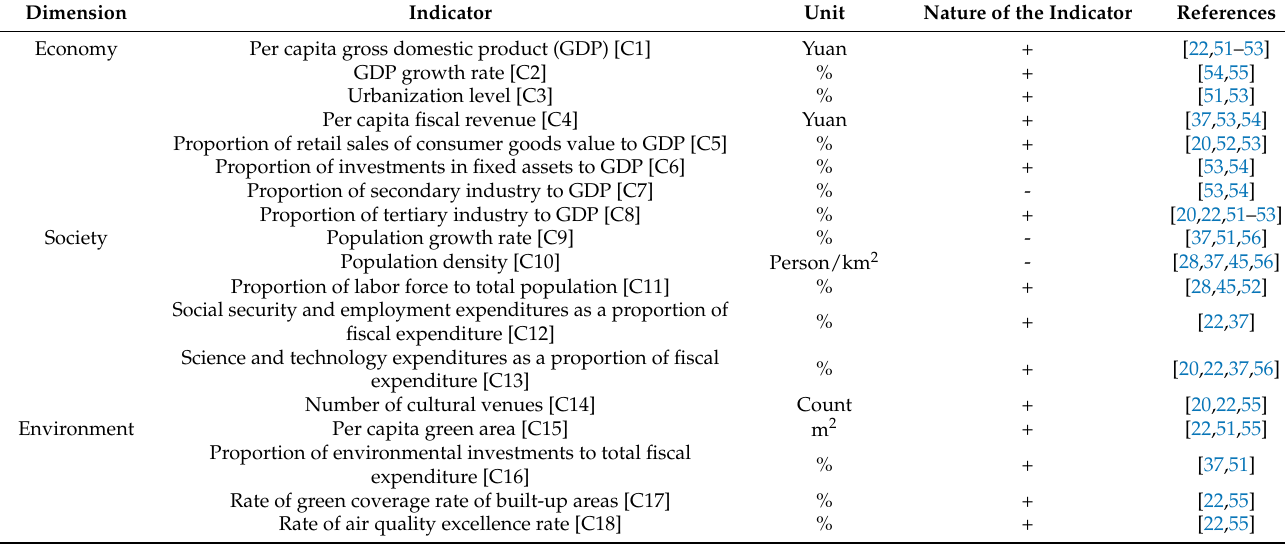
Table 1. Evaluation index system of urban vitality in Shanghai. Dimension Indicator Unit Nature of the